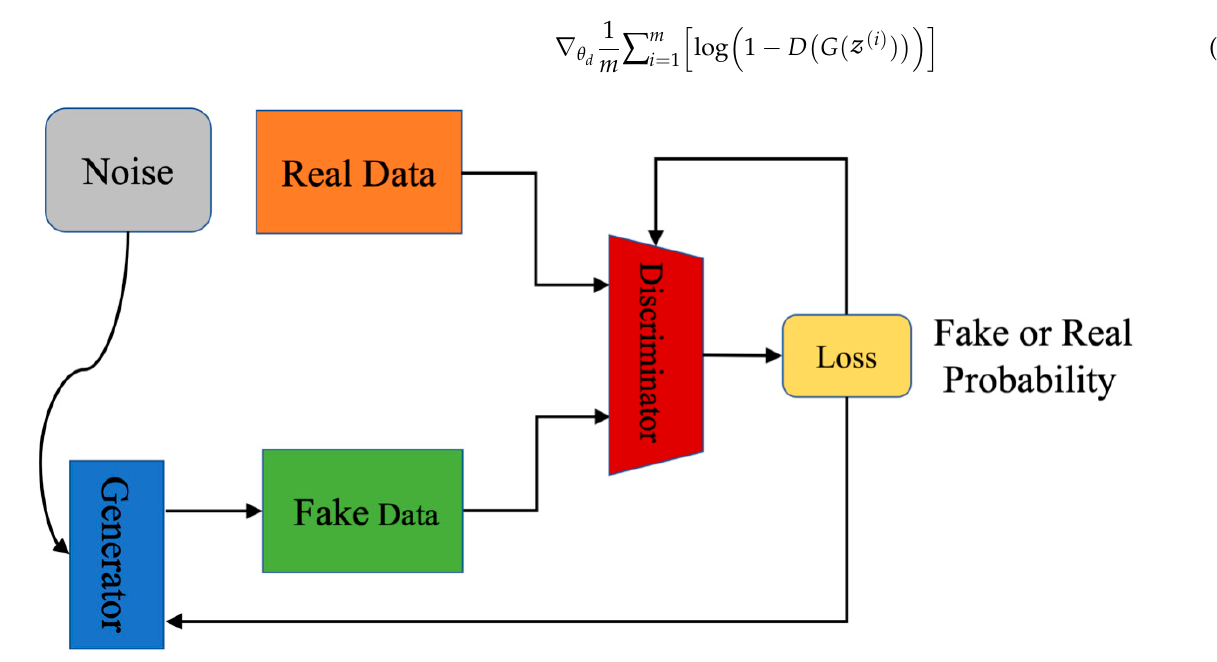
Figure 1. The structure of the standard GAN.